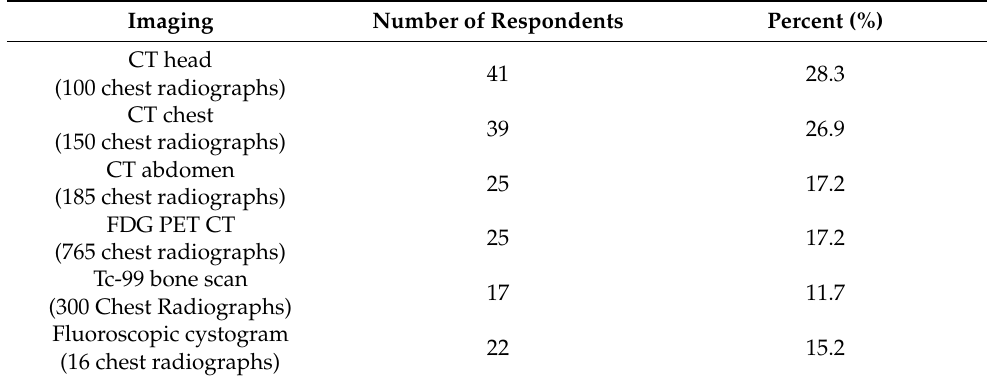
Table 4. The number of respondents that correctly estimated the chest radiograph equivalent effective dose for ionizing radiation-related medical imaging in an average 5-year-old child.